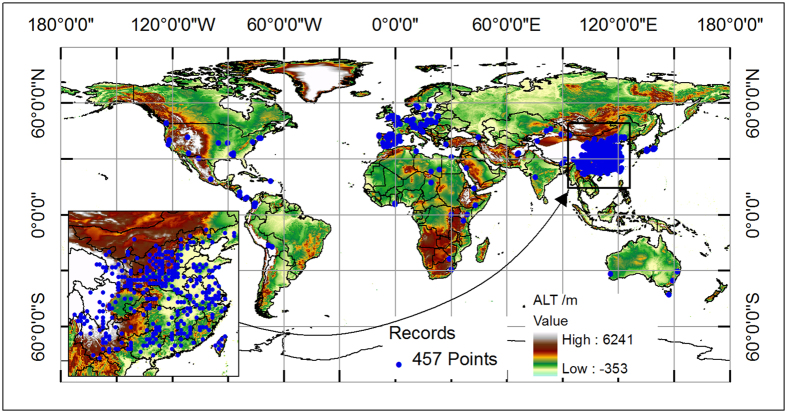
Global spatial distribution of occurrence records (457 points) of oriental arborvitae with a grid cell of 0.5° × 0.5° resolution and spatial distribution of altitude around the world (altitude layer come from website: http://www.worldclim.org/).It shows that the altitude distribution of oriental arborvitae from 0 to 4526 m (1st. Qu. 128 m, Median 492 m, Mean 795 m, and 3rd Qu. 1132 m). The whole map is generated by using the tool of ArcGIS 9.3 (ESRI, Redlands, CA, USA, http://www.esri.com/).